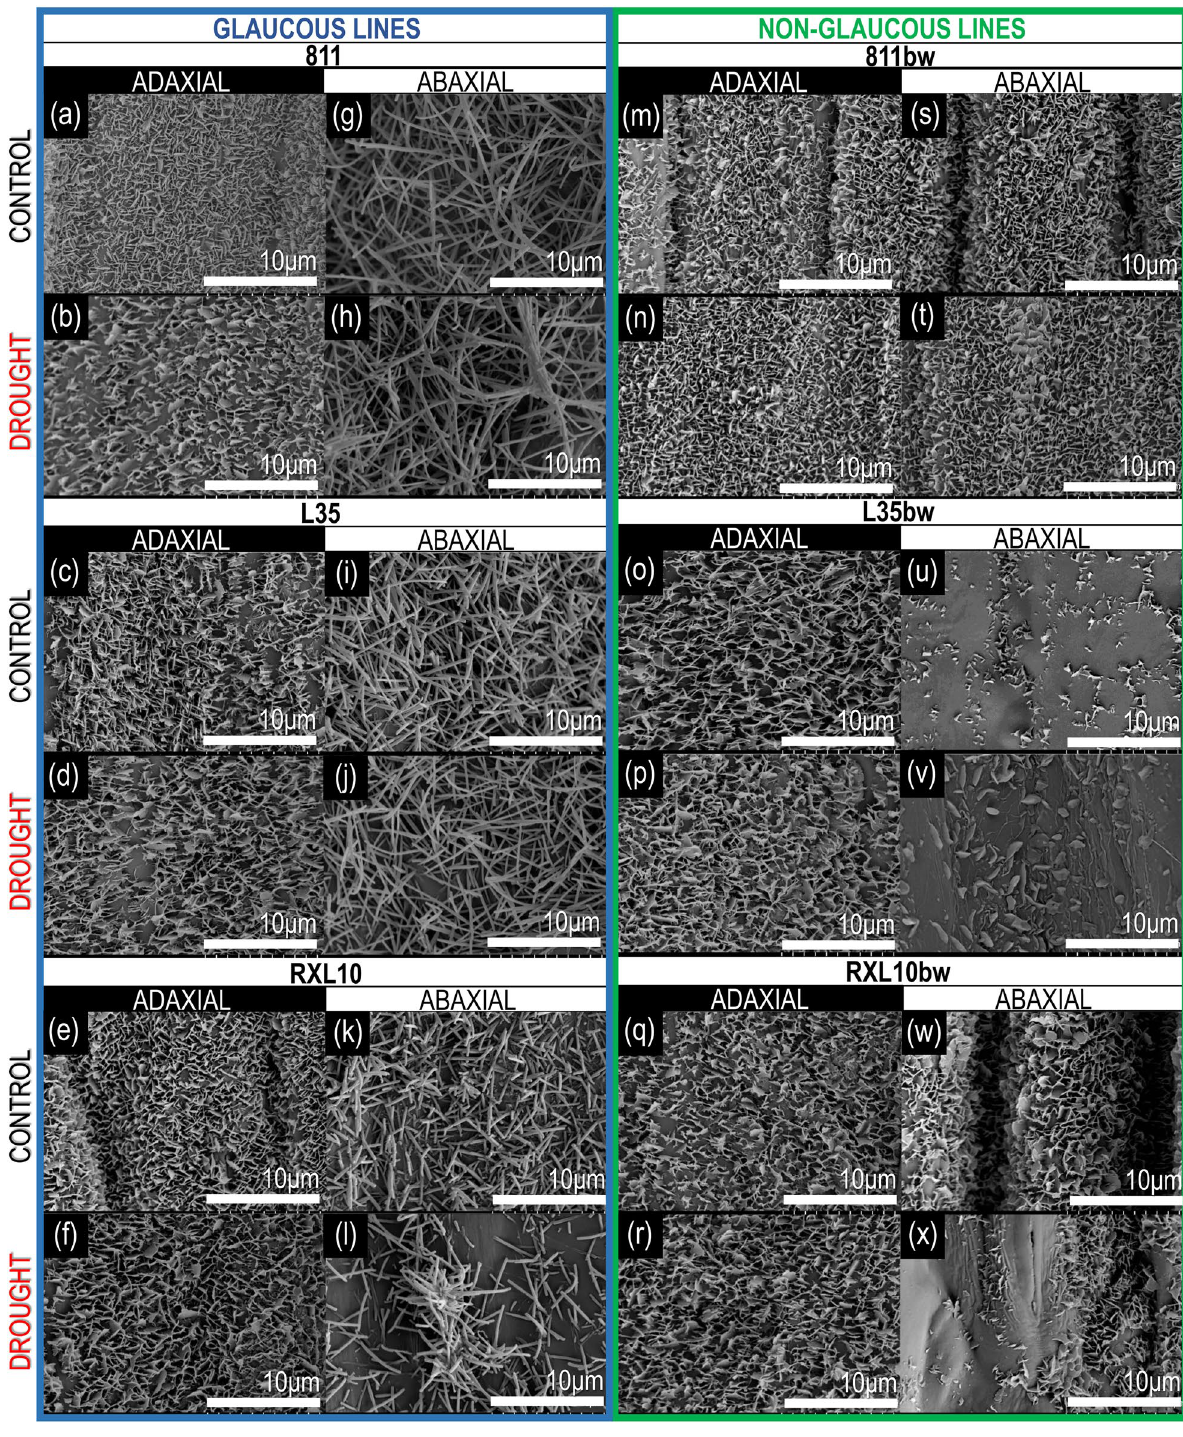
RXL10bw ( q , r , w , x ) under control and soil drought stress conditions. 10 μm